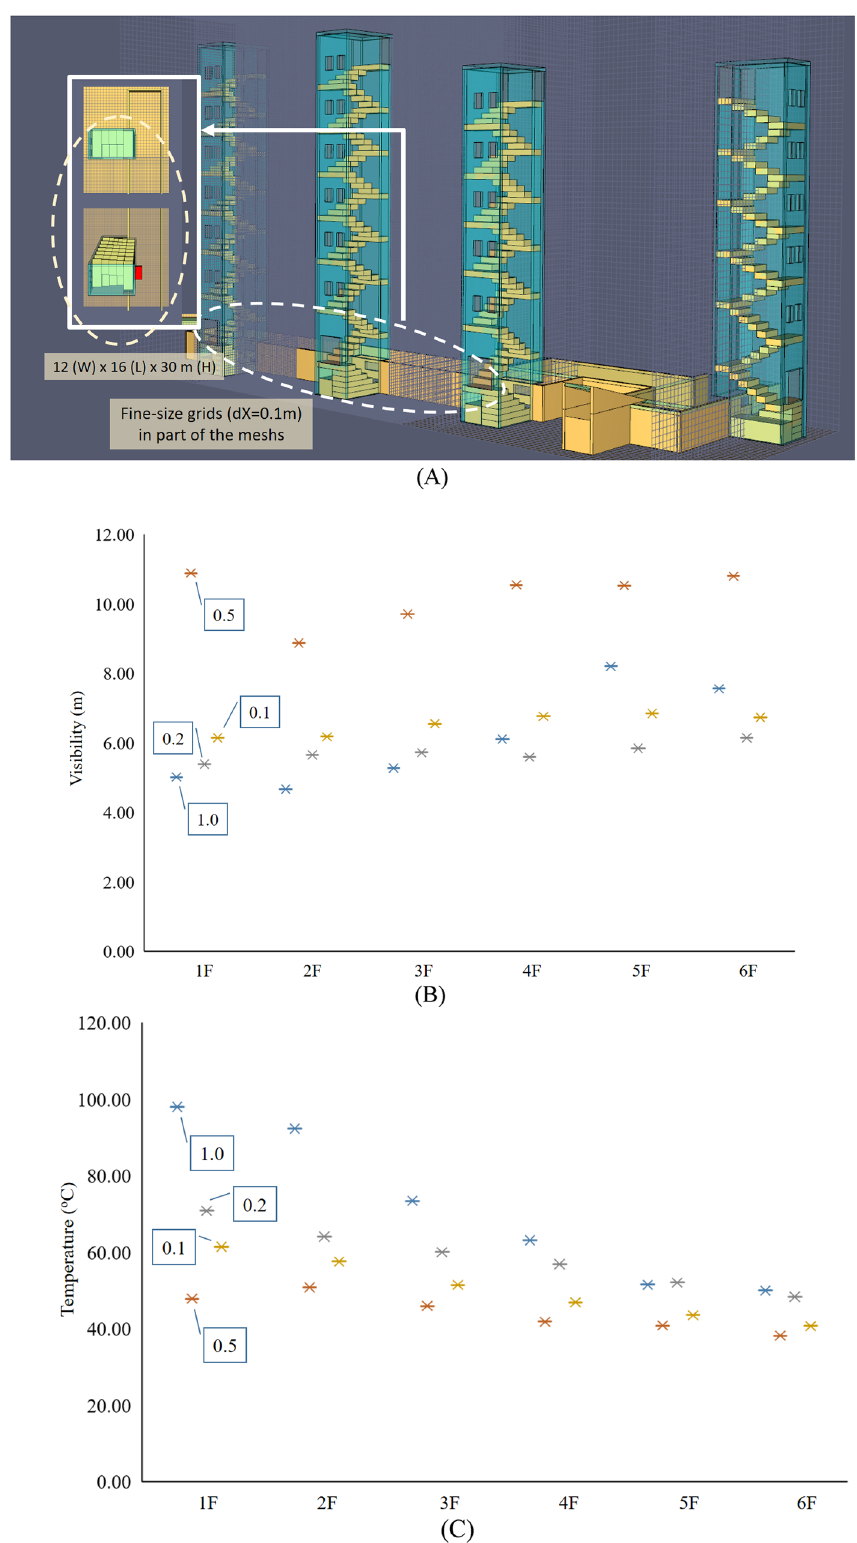
Figure 7. Sensitivity analysis of the tested model in four grid sizes (dx = 1.0, 0.5, 0.2, 0.1 mm). ( A ) Tested model. ( B ) Visibility. ( C )